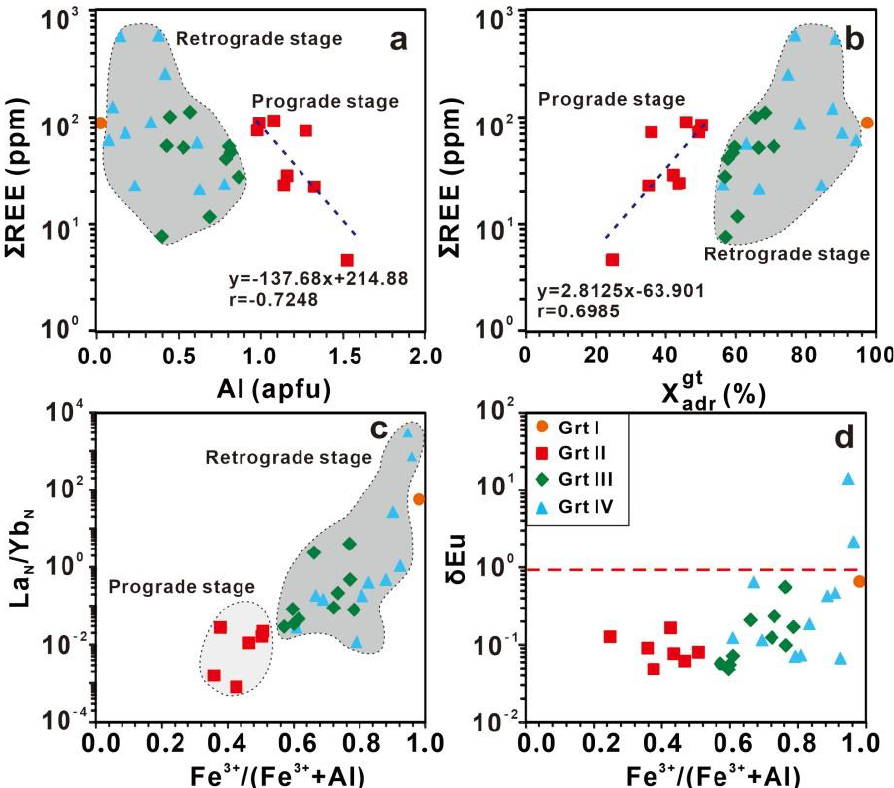
Figure 12. ( a ) Total REE concentrations (∑ REE) versus total Al in atoms per formula unit (apfu) for garnets from the Huanggang deposit. ( b ) ∑ REE versus percentage of the andradite (adr) end-member component in garnets. ( c ) LREE/HREE fractionation versus Fe 3+ /(Fe 3+ + Al) ratio of garnets. ( d ) Eu anomaly (δEu) versus Fe 3+ /(Fe 3+ + Al) ratio of garnets.